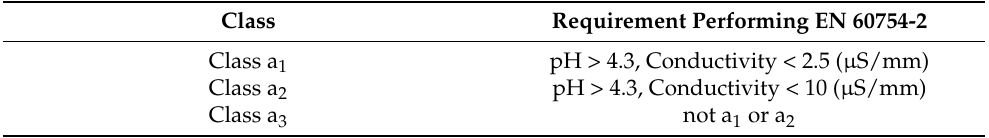
Table 1. Additional classification for acidity and requirements according to EN